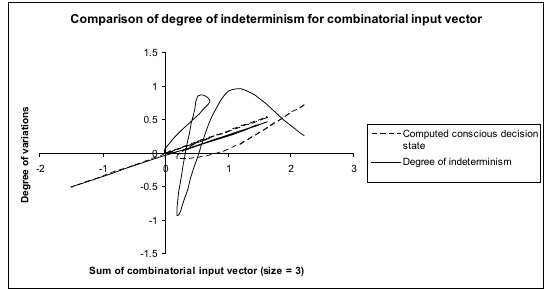
Fig. 13. Variation of state of consciousness in C2 (size =